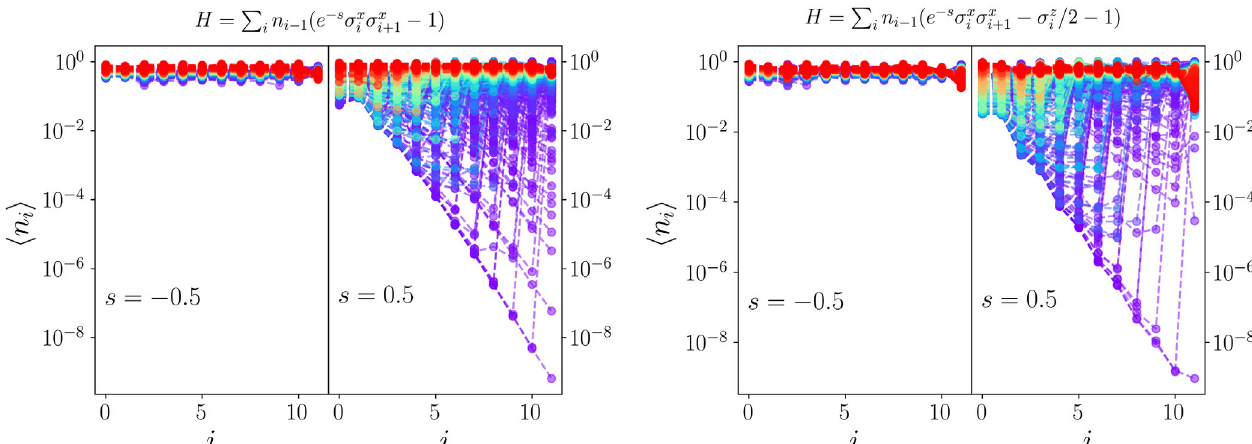
FIG. 14. Examples of other localized models. As in Fig. 7 (right panel), we plot the expectation value of the occupation as a function of the support for two constrained Ising models. Both exhibit an exponential localization for positive values of s and no localization for negative values ( N ¼ 12 ). In the localized phase, there are several other localized excited